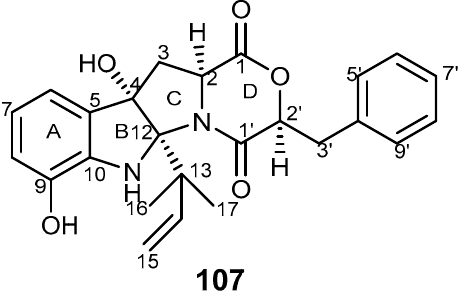
Figure 22. Structure of shornephine A ( 107 ).